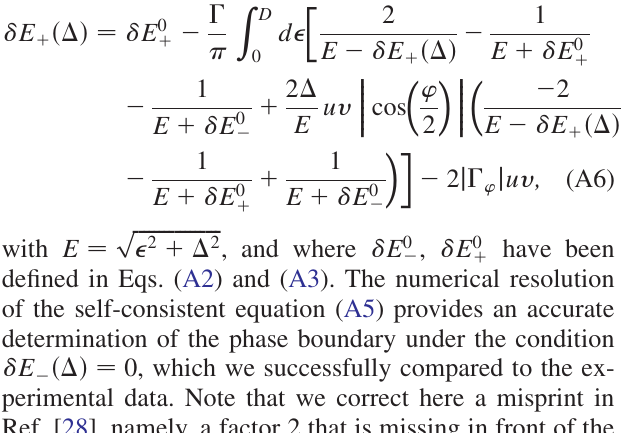
FIG. 8. Conductance map of JJ1 for two values of the backgate voltage. Extending the diamond edges (black lines) to finite bias allows us to extract the Coulomb repulsion of the dot U ¼ 0 : 80 (cid:3) 0 : 05 meV , where 2 U is defined as the energy separation between the two horizontal dashed lines.